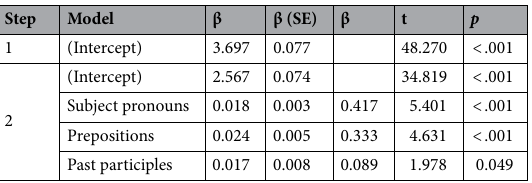
Table 5. Regression model predicting MLU-m on Function